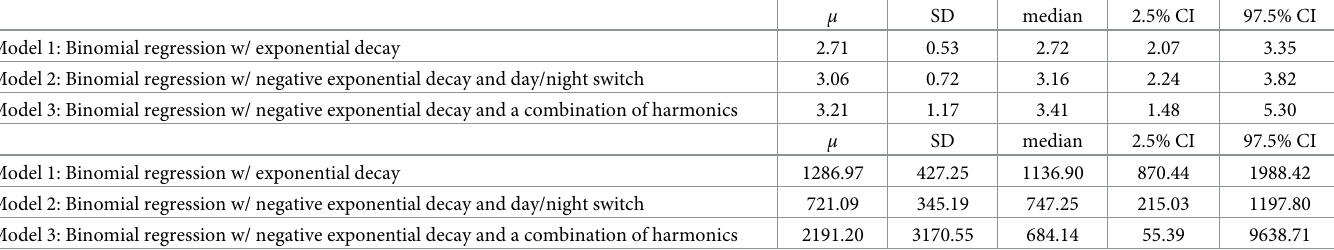
Table 3. Estimated parameters from binomial regression models predicting headshaking in scimitar-horned oryx ( Oryx dammah ) after being fit with GPS collars. Results summarize the joint posterior distributions across each individual ( n = 4). Model 3 (Binomial regression with a negative exponential decay and a combination of harmonics) best fit the data in three out of four animals. Model 2 (Binomial regression with a negative exponential decay and a day/night switch) outcompeted the har- monic model in one of our animals. Half-life is the time (hours) required for the treatment effect (collar fitting) to decline to half its initial magnitude. Treatment Effect [( Handling Rate–Recovery Rate)/Recovery Rate � 100] is the percent increase in headshaking when comparing the rate of headshaking after being fit with GPS collars ( Han- dling Rate ) with the background rate ( Recovery Rate ). Model parameters and results from leave-one-out cross-validation provided in S3 Cross Validation. Model 1: Binomial regression w/ exponential decay Model 2: Binomial regression w/ negative exponential decay and day/night switch Model 3: Binomial regression w/ negative exponential decay and a combination of harmonics